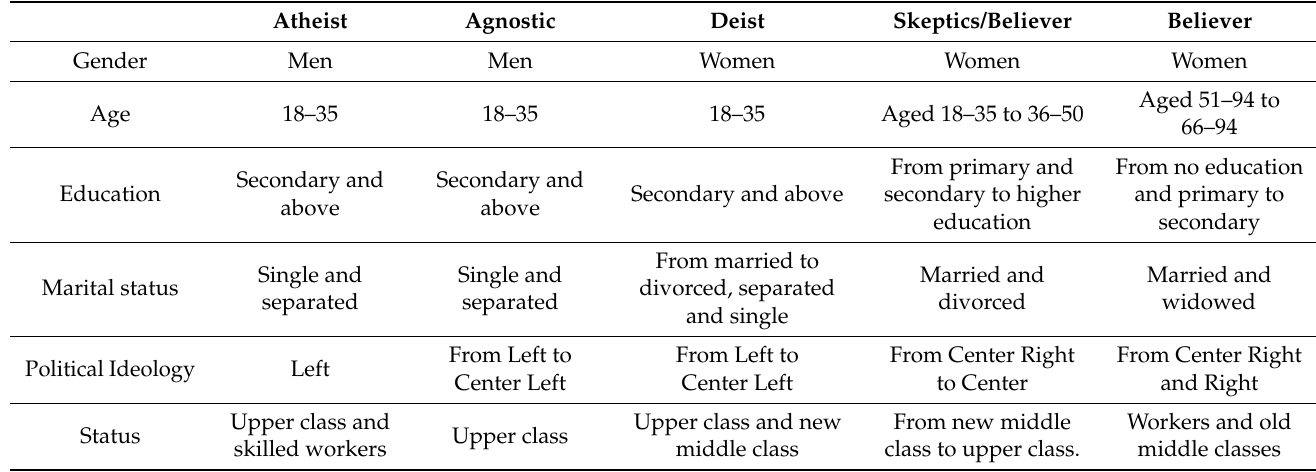
Table 3. Profiles of religious options and their